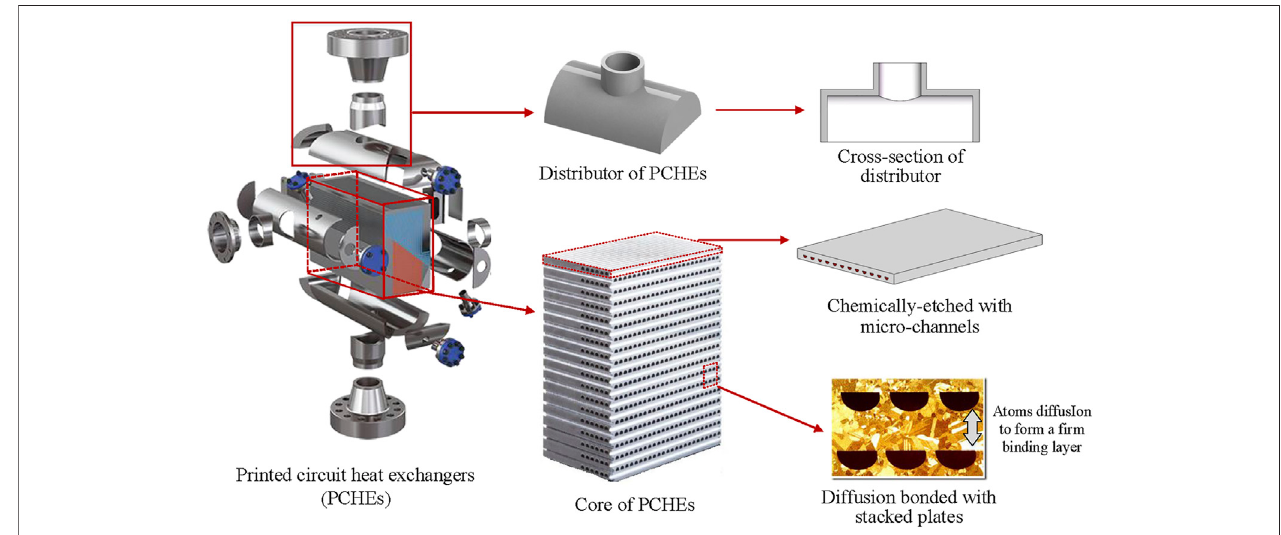
FIGURE 1 | Structure of printed circuit heat exchangers (Heatric, 2008; Ma et al., 2015; Huang et al., 2019; Ma et al.,